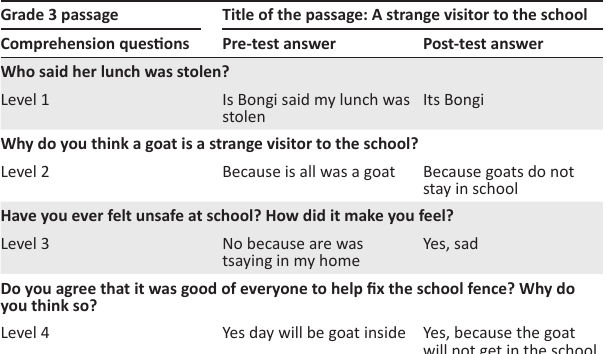
TABLE 3: L3’s written pre-test and post-test